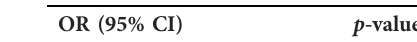
TABLE 2 Logistic regression analysis of the risk factors for DM in the training